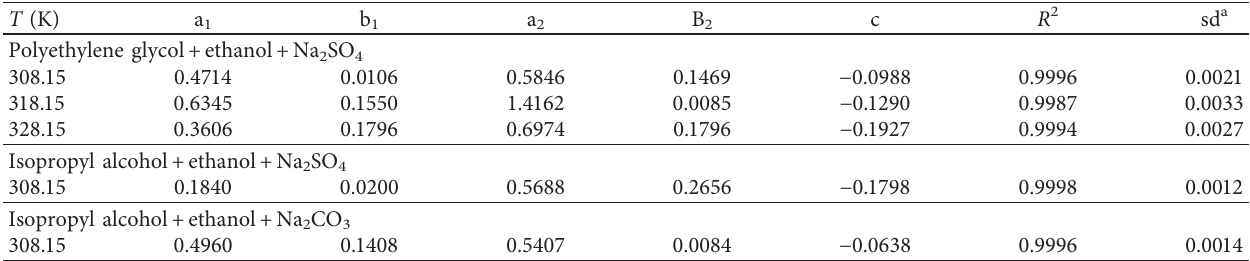
2 CO 3 /Na 2 SO 4 )+water